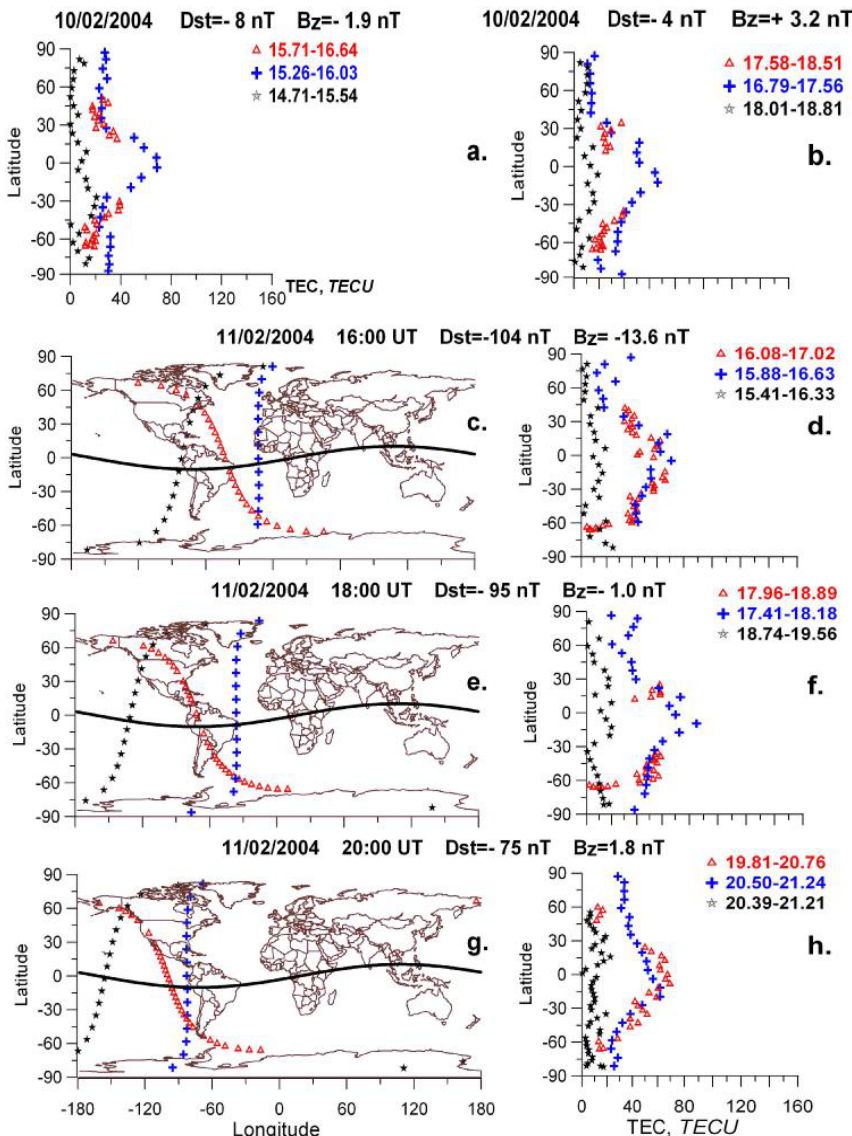
Fig. 4. The same as in Fig. 3 but for quiet day 10 February 2004 (a) , (b) and the geomagnetic storm on 11 February 2004 (c–h) . The satellites pass near the following sectors: Jason-1 ∼ 13:40LT, CHAMP ∼ 15:30LT, SAC-C ∼